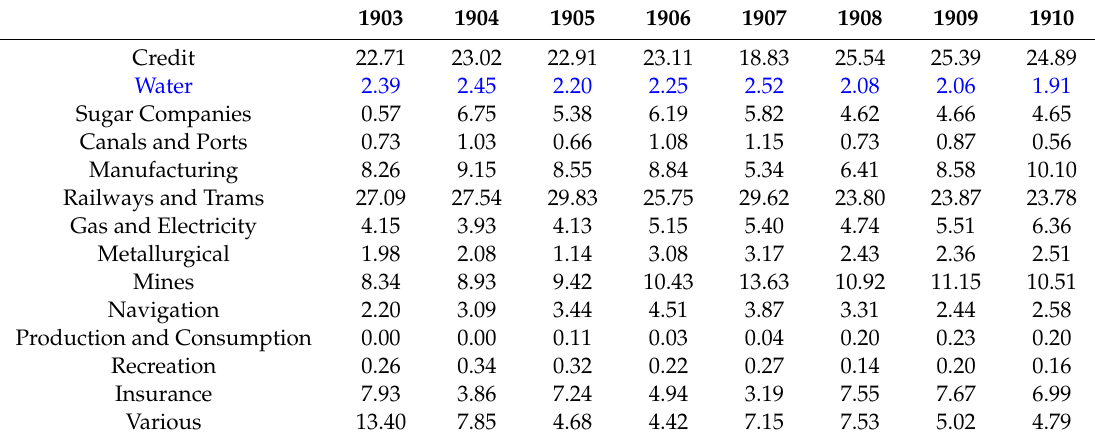
Table 3. Percentage distribution of the capitals of the di ff erent sectors between 1903 and 1910.